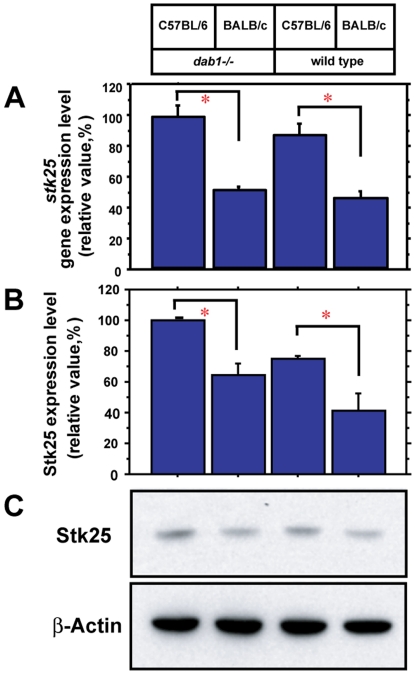
Stk25 mRNA and protein levels are strain-dependent.
A Stk25 mRNA expression was 1.8-fold higher in C57BL/6 versus BALB/c strain in dab1 −/− and wild-type mice by real-time PCR. B Western blot analysis of Stk25 protein levels showed higher levels of expression in dab1 −/− and wild-type mutant animals on the C57BL/6 than the BALB/c strain. C Representative anti-Stk25 (upper panel) and anti-actin (lower panel) Western blots of hippocampal lysates.